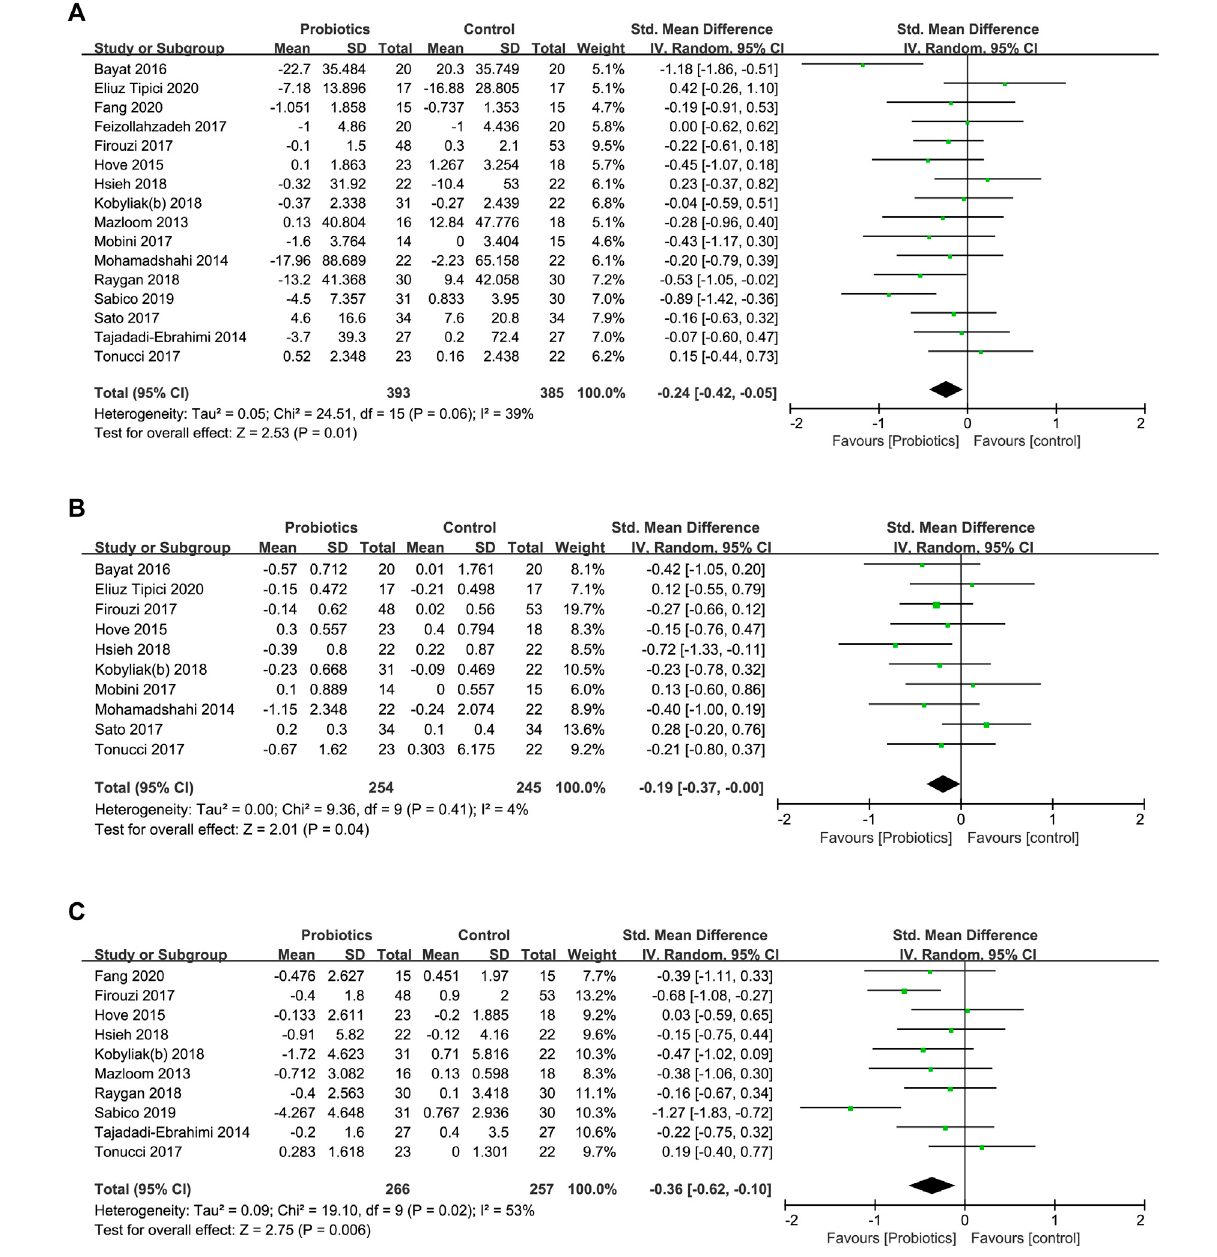
Frontiers in Pharmacology |